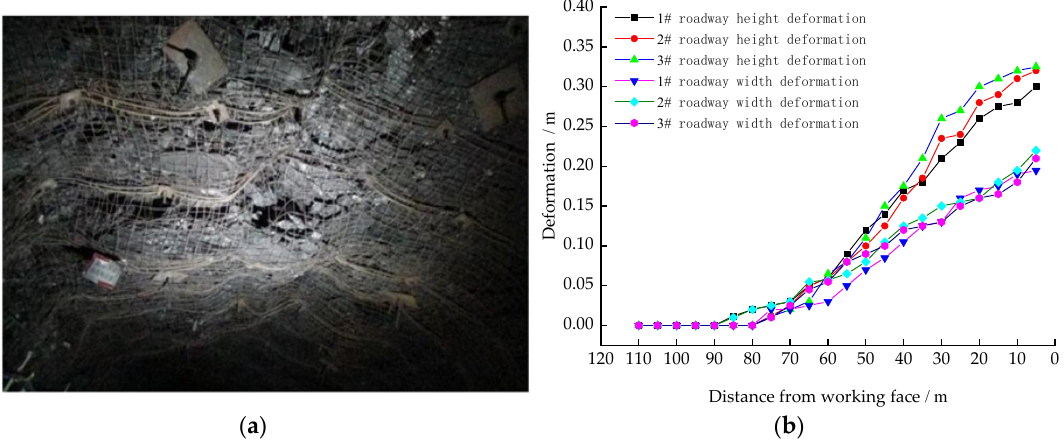
Figure 18. Engineering practice monitoring results. ( a ) Deformation monitoring of transportation lanes; ( b ) stability monitoring curve of transportation roadway.